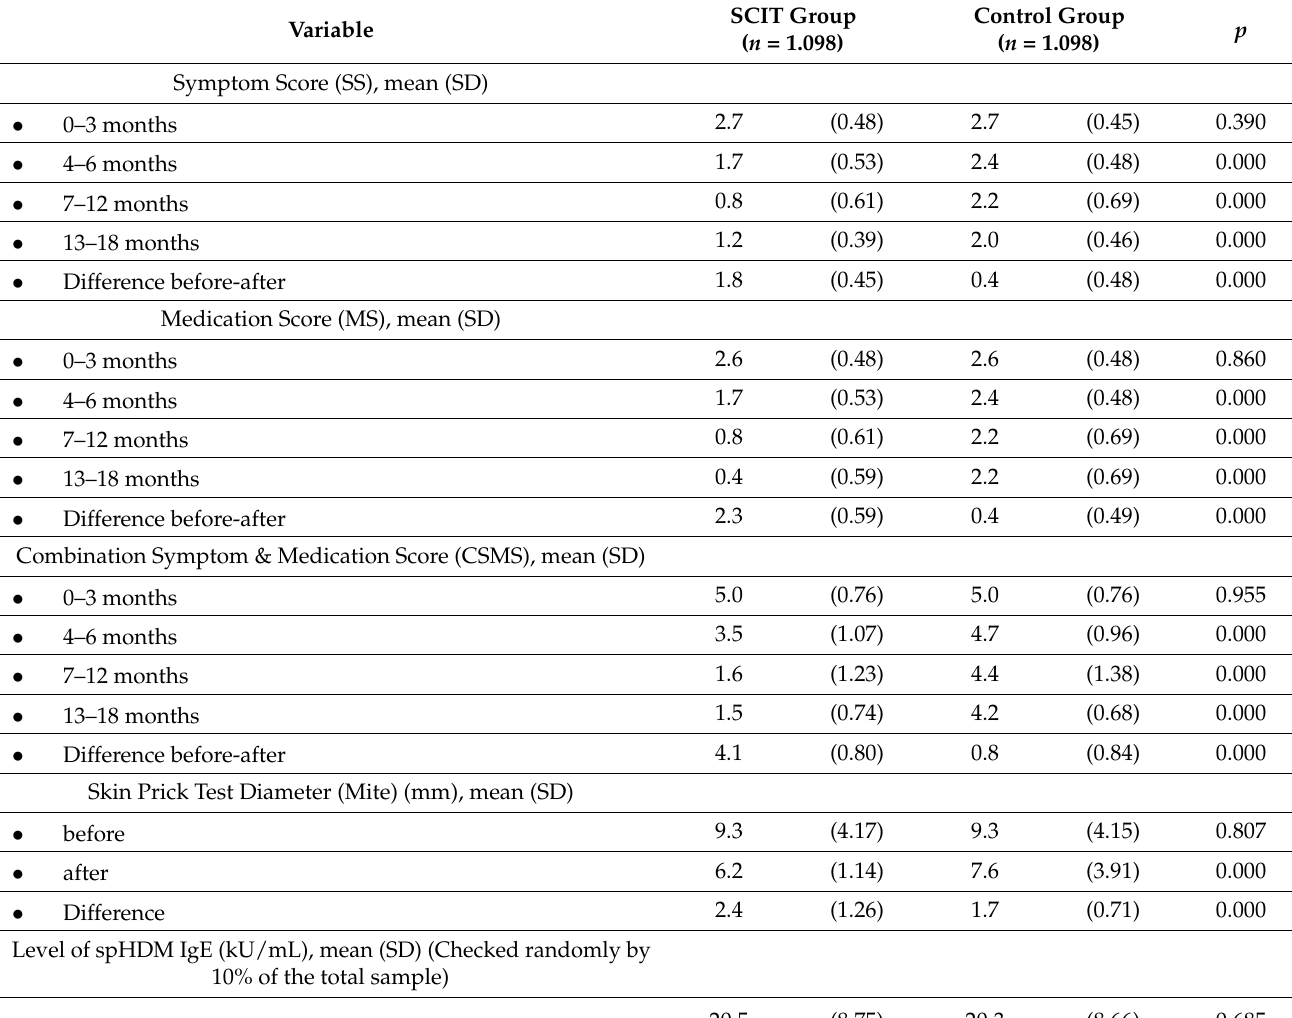
Table 2. The effect of SCIT on symptom scores, drug scores, SPT of house-dust-mite diameter, IgE-specific house-dust-mite. Variable